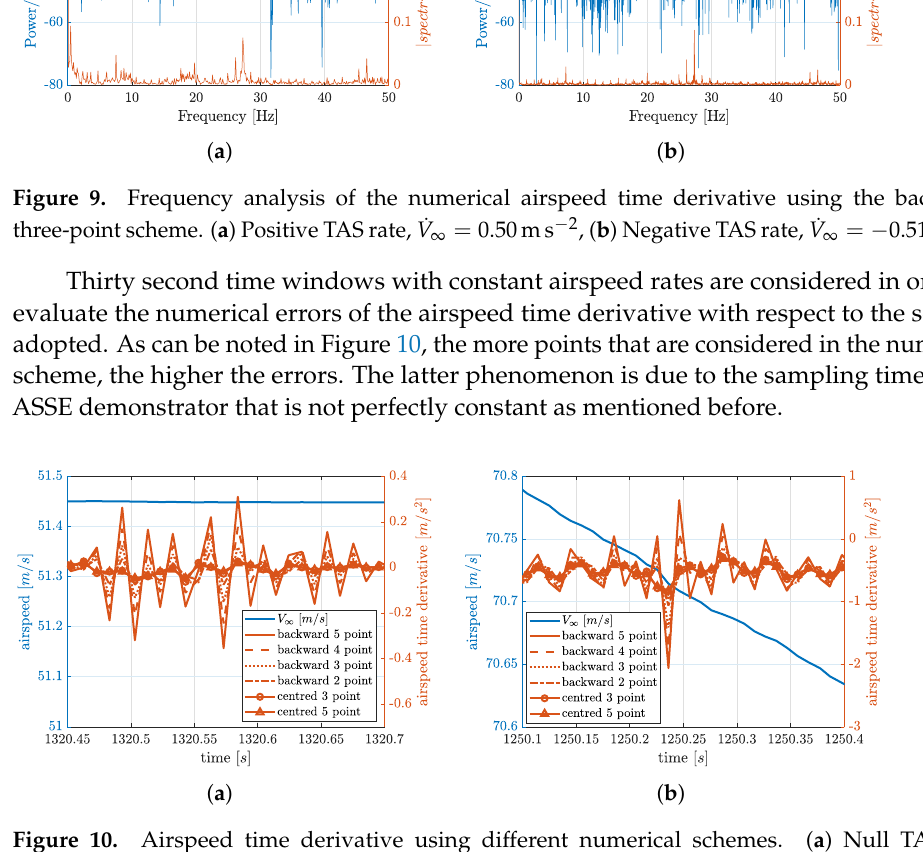
Figure 10. Airspeed time derivative using different numerical schemes. ( a ) Null TAS rate, ˙ V ∞ = 0.01ms − 2 , ( b ) Negative TAS rate, ˙ V ∞ = − 0.51ms − 2